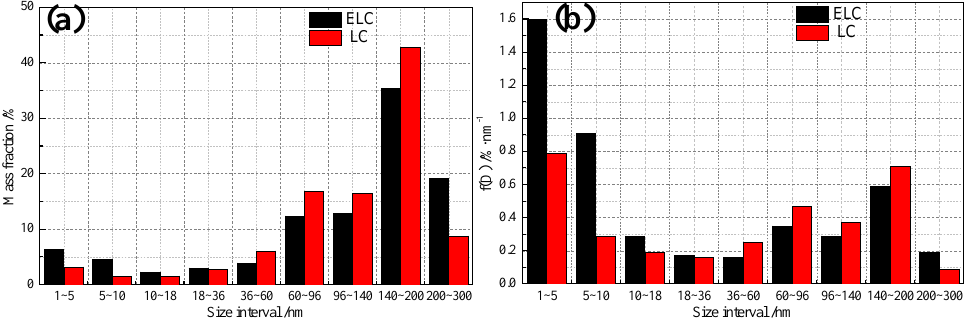
Figure 5. Comparison of particle size distribution with different C content. ( a ) mass fraction; ( b ) mass density.